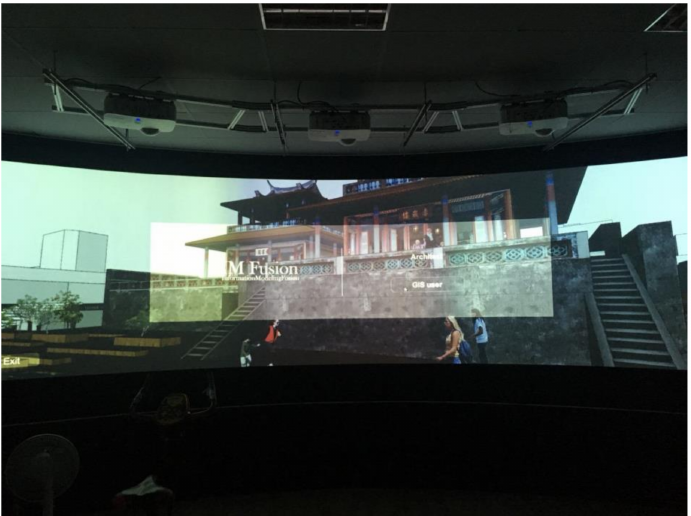
Figure 18. iSpace achievement exhibition of the Urban Planning and Spatial Information Department of Feng Chia